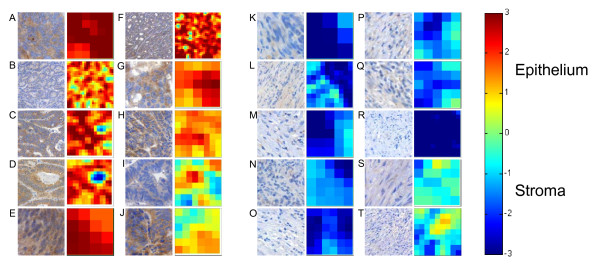
Example images of epithelial and stromal tissue in the test set (colorectal cancer images; n = 720). A-H represents examples of histological images that have been strongly- and I-J images that have been weakly classified as epithelium by the local binary pattern classifier. K-R represents examples of tissues that have been strongly assigned into stroma, and S-T images that have been weakly classified as stroma